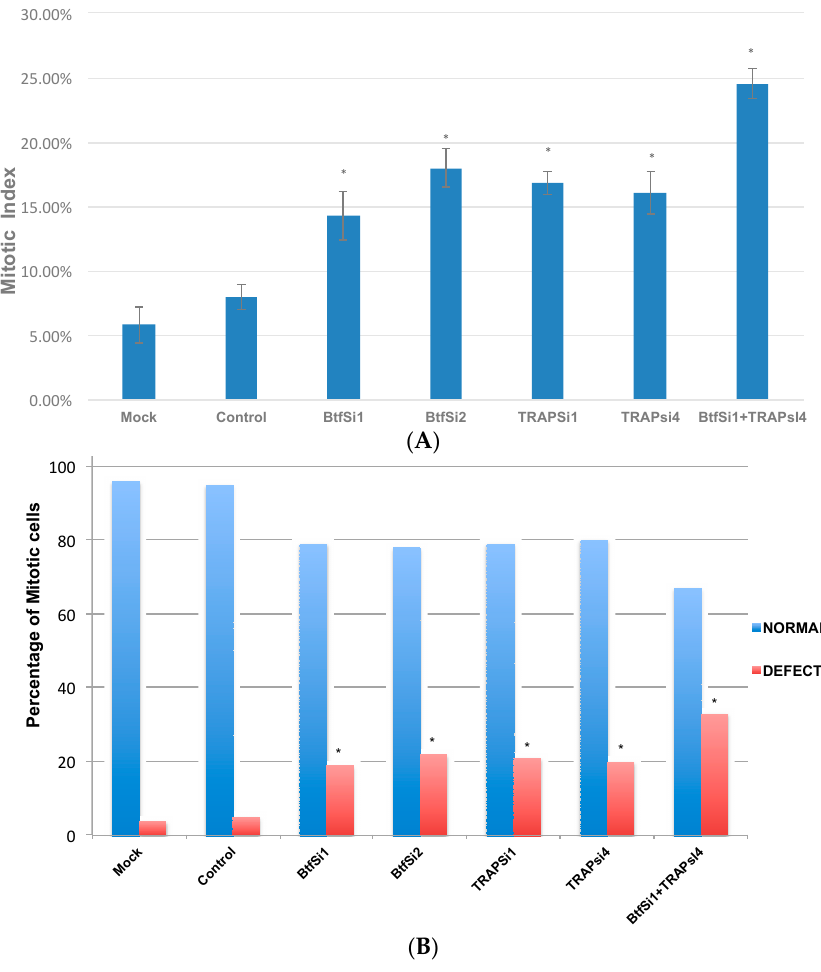
Figure 2. Absence of Btf and/or TRAP150 alters cell cycle distribution. ( A ) Mitotic index was scored in three replicate experiments for HeLa cells treated with mock conditions, control siRNA duplexes, or siRNA duplexes; ( B ) In a separate experiment, 100 metaphase cells were scored as “normal” or “defective” regarding metaphase chromosome alignment. Asterisks in both tables indicate significant difference from control ( p -value ≤ 0.001).